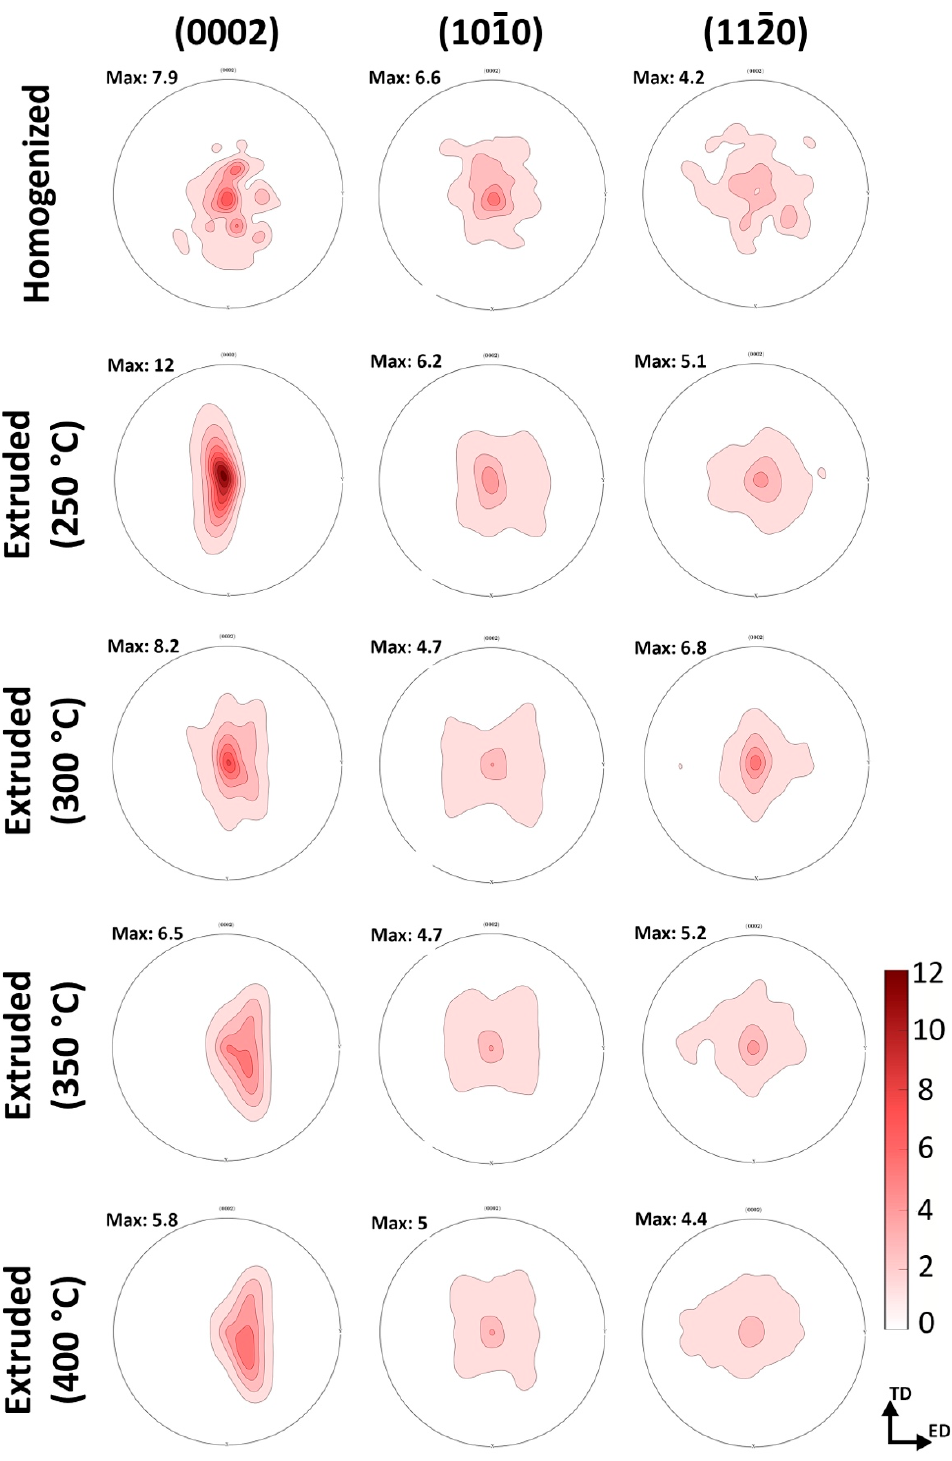
Figure 7. The (0002), (10 1(cid:3364) 0), and (11 2(cid:3364) 0) pole fi gures of the homogenized and extruded